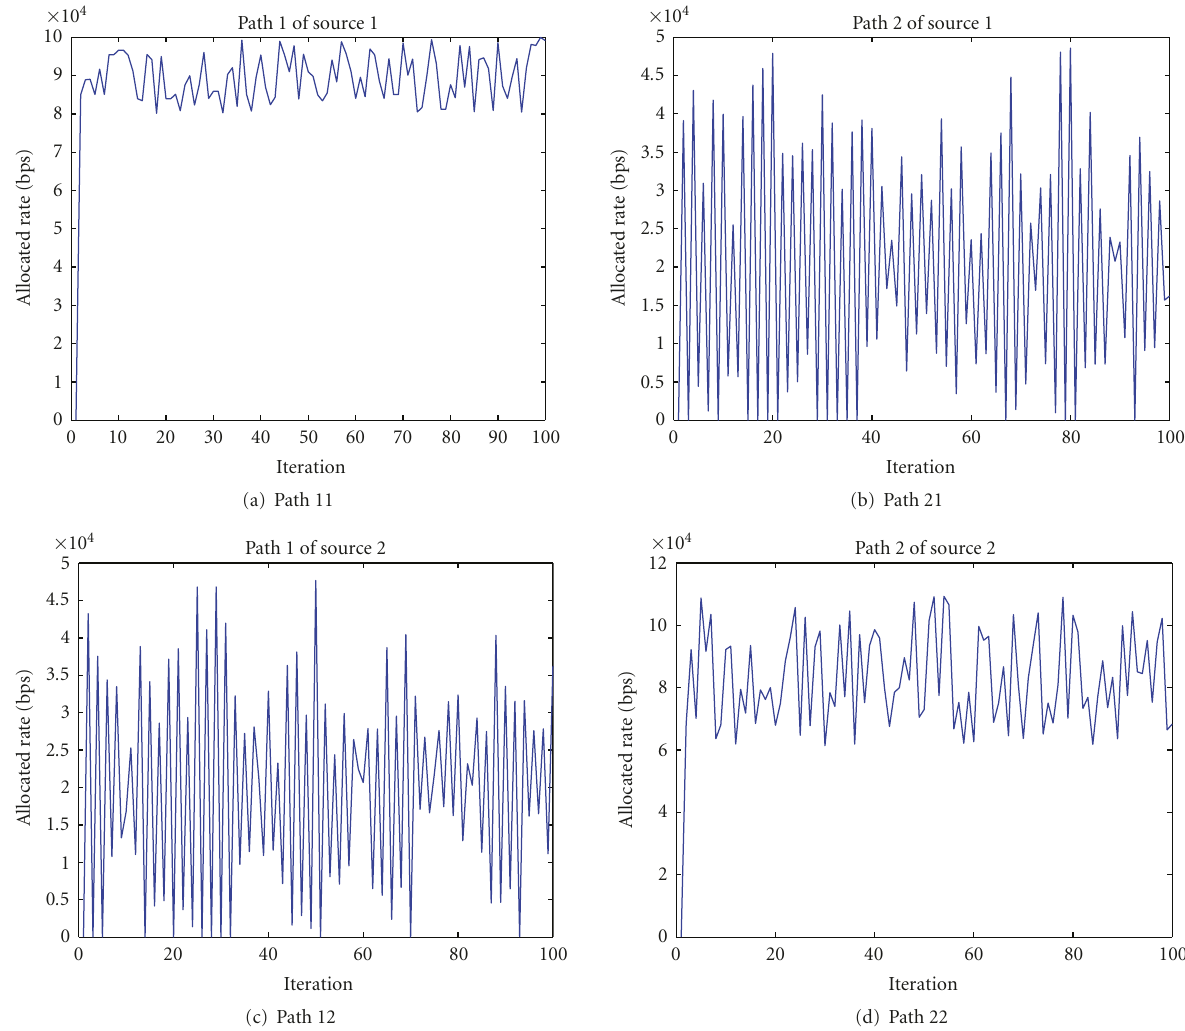
Figure 4: Rate allocation to di ff erent paths of the two